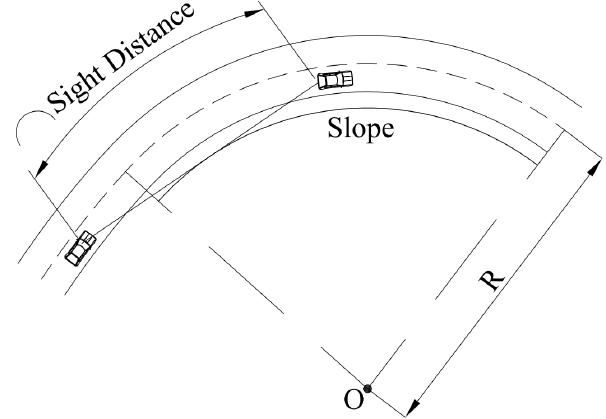
Figure 1. Sight distance within the limits of high slope.